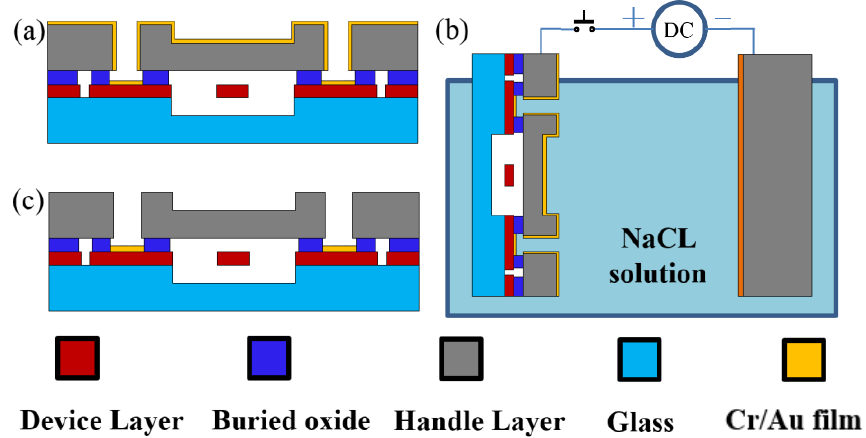
Figure 4. The schematic of selective pad patterning in via holes based on the electrochemical dissolution of gold. ( a ) Cr/Au film deposition; ( b ) Electrochemical etching. ( c ) Gold portions in via holes were preserved.